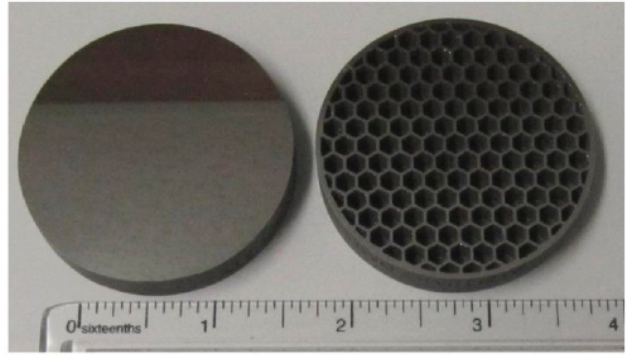
Figure 14. DMLS Mirror with Corning enhanced performance surfacing process [17].